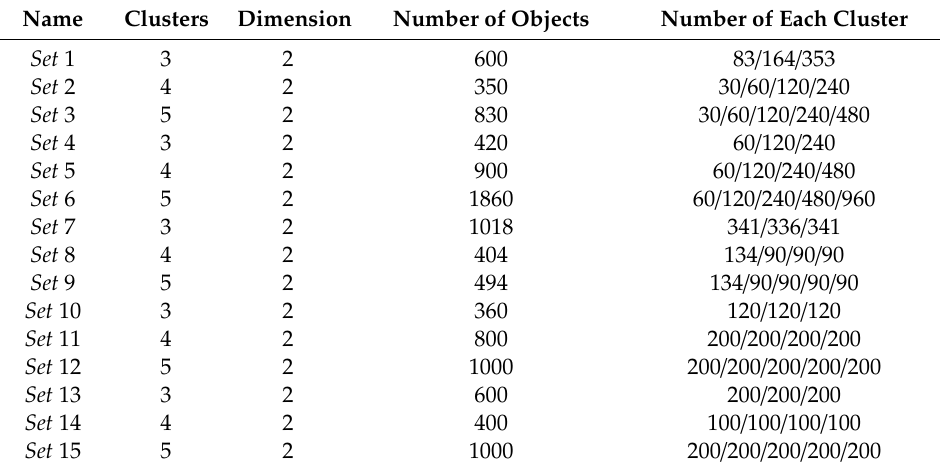
Table 2. Characteristics of 15 datasets in Figure